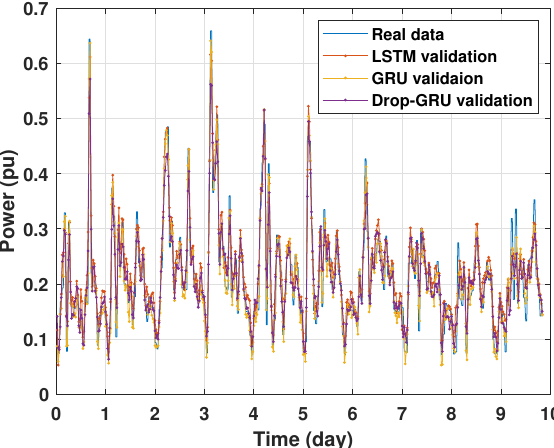
Figure 10. Training and validation for 3 days forecasting.